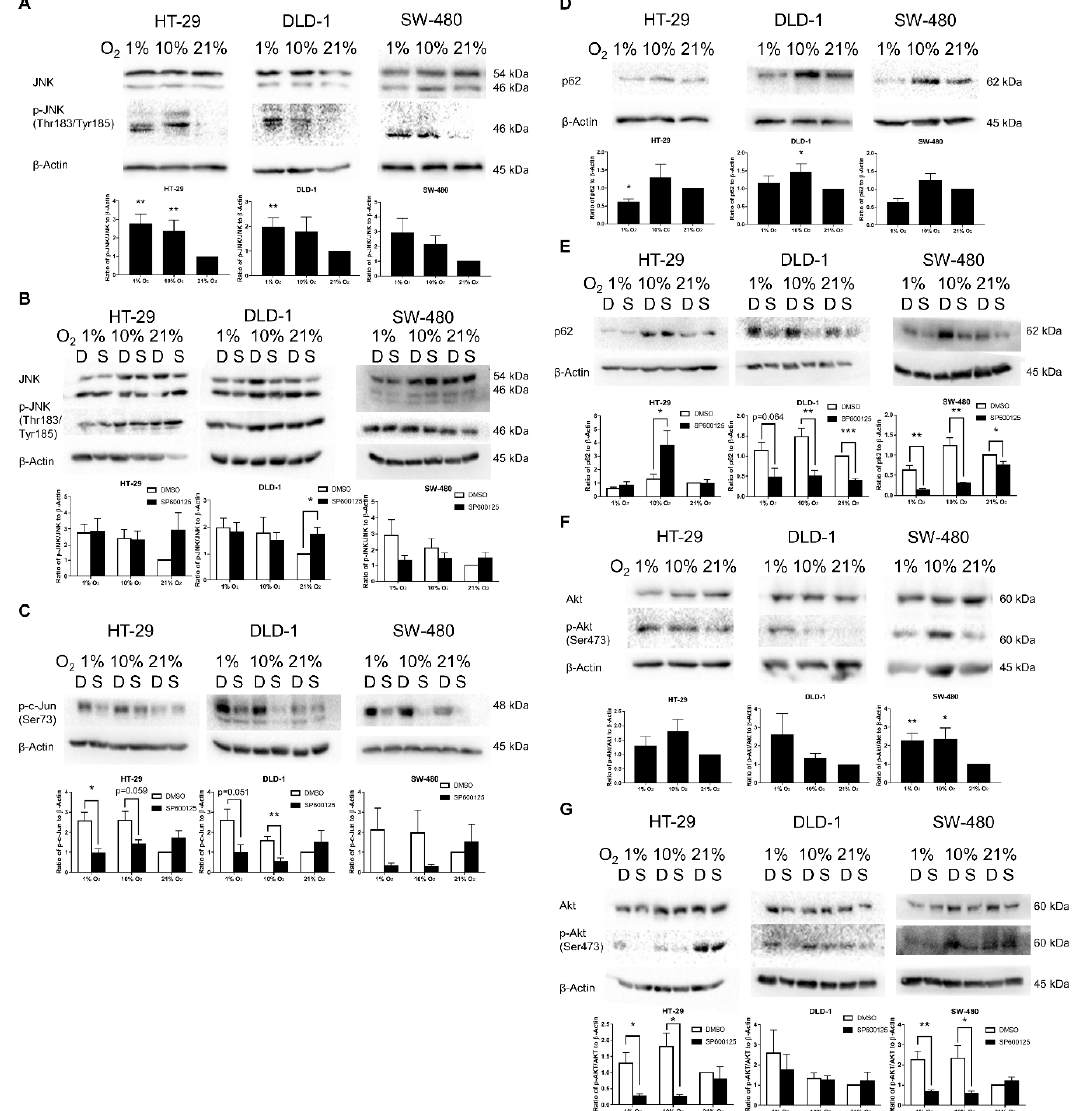
Figure 5. JNK and Akt pathway activation under different oxygen levels. The key markers of JNK pathways were evaluated by Western blotting. JNK was activated under lower oxygen levels in HT-29, DLD-1, and SW-480 with significant promotion in HT-29 and DLD-1 ( A ) There were generally mild reductions in JNK phosphorylation status by SP600125 (10 µM) in 1% and 10% O 2 among the three cell lines, with greater effects on SW-480, while JNK phosphorylation was slightly promoted in 21% O 2 ( B ) For the JNK direct downstream target c-Jun, its phosphorylation status p-c-Jun has been largely suppressed by SP600125 in lower oxygen levels, with significant reductions found in HT-29 and DLD-1 ( C ) The indirect downstream effector of JNK pathway p62 showed mild up-regulation in 10% O 2 and down-regulation in 1% O 2 ( D ) In the presence of SP600125, significant down-regulations